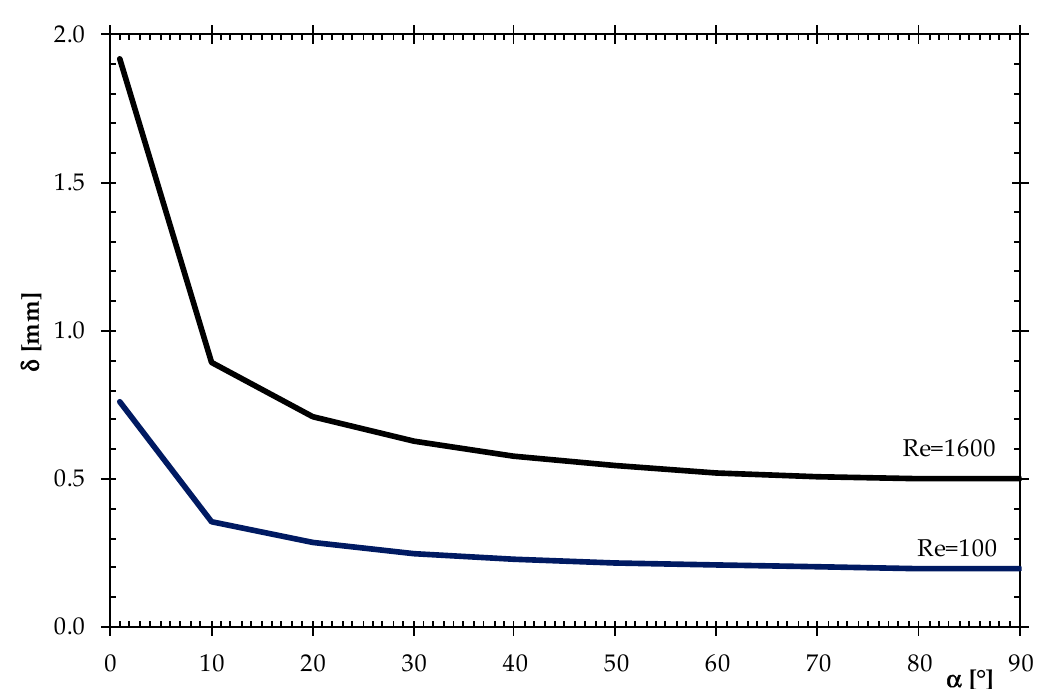
Figure 2. Film thickness δ as a function of surface inclination towards the horizon.